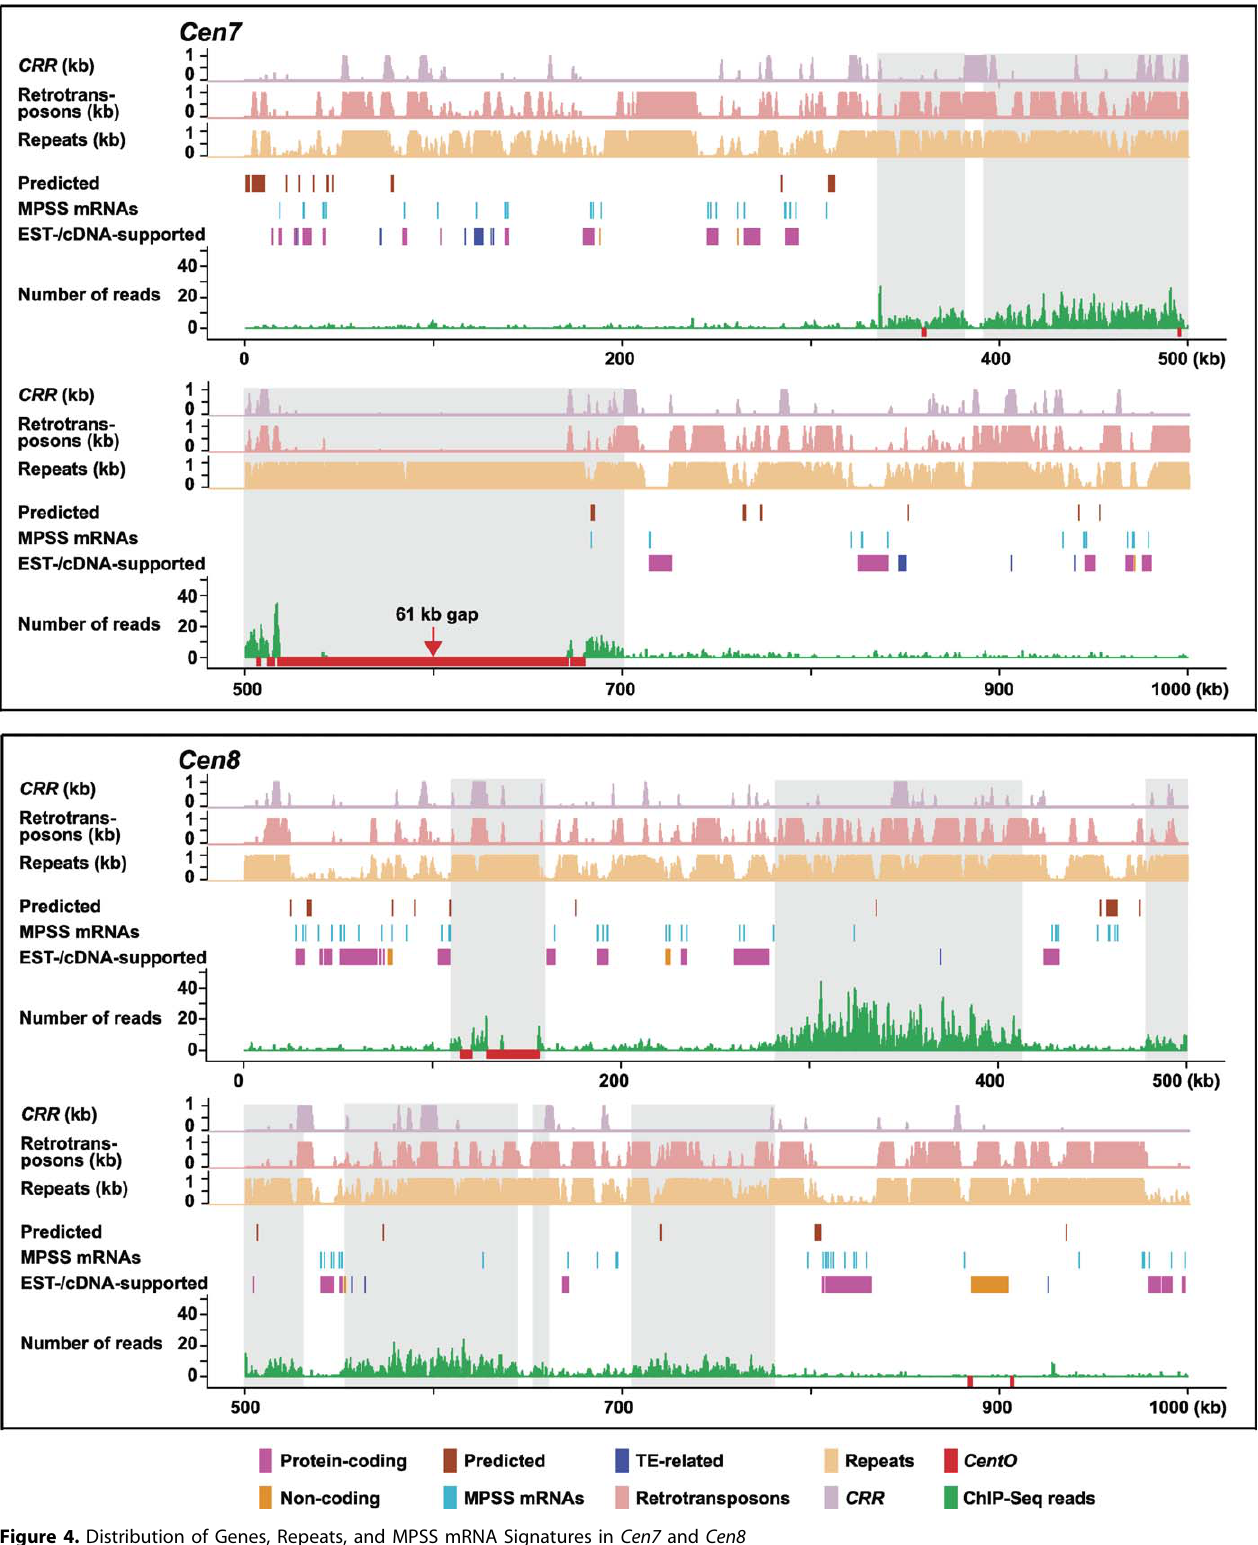
Figure 4. Distribution of Genes, Repeats, and MPSS mRNA Signatures in Cen7 and Cen8 Repeats are defined as those that have 20 or more copies in the genome and plotted using a 1-kb window. CRR centromere-specific retrotransposons and other retrotransposons are plotted separately from the remaining repeats. Transcribed regions supported by ESTs or cDNAs are annotated as non– TE-related protein-coding genes, TE-related genes, or noncoding regions. Predicted genes (http://rice.plantbiology.msu.edu/) and MPSS mRNA signatures (http://mpss.udel.edu/rice/) were downloaded from public databases. Major CENH3-binding subdomains ( . 5 kb in size) are highlighted as in Figure 3. Two MPSS tags within the highlighted subdomains of Cen8 fall within individual 1-kb windows that are not enriched in CENH3, whereas the single MPSS tag in Cen7 is in a CENH3-enriched window. doi:10.1371/journal.pbio.0060286.g004 PLoS Biology |